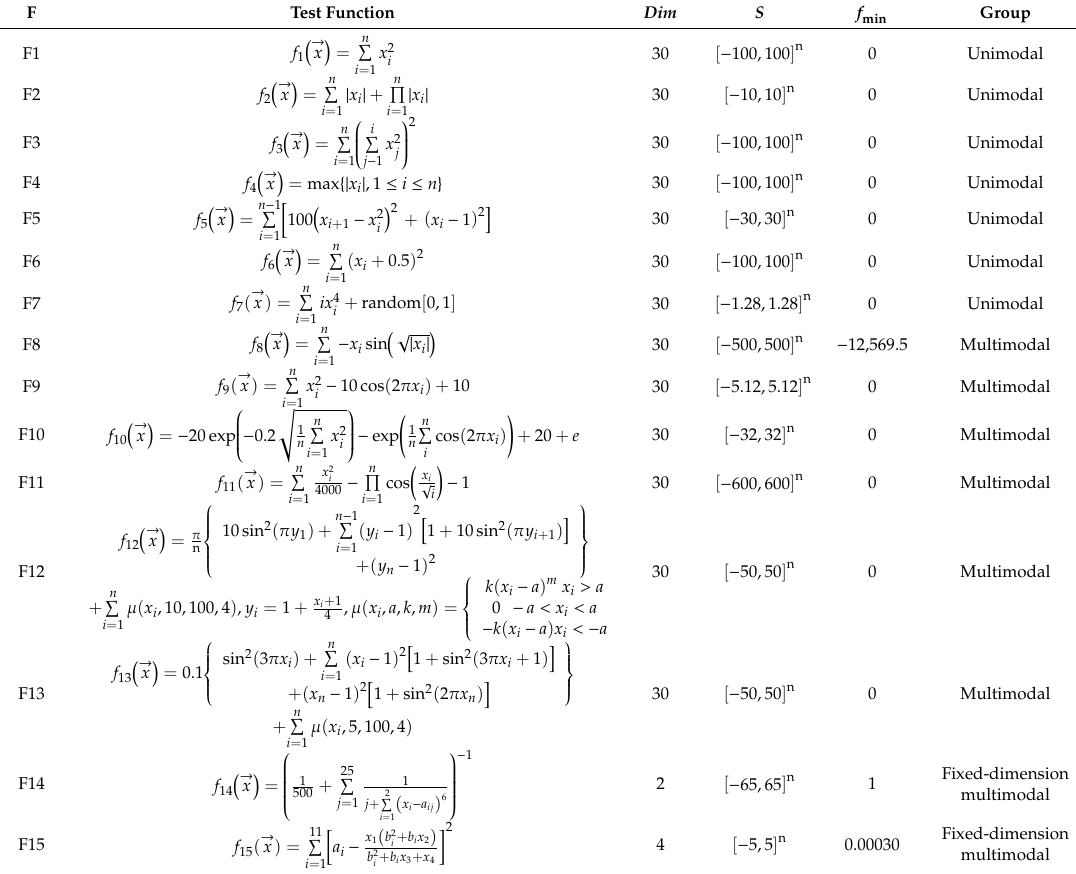
Table 1. Benchmark